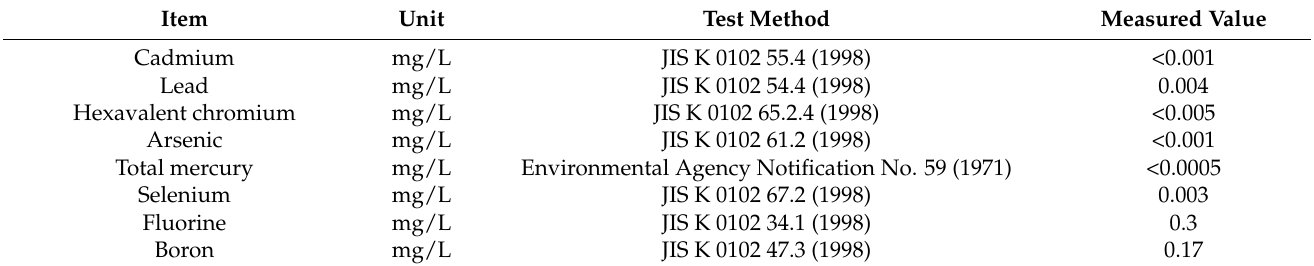
Table 4. Results of the elution test for using a sample of the solidifying material with the mixing type of ES additive coarsely crushed to less than 2